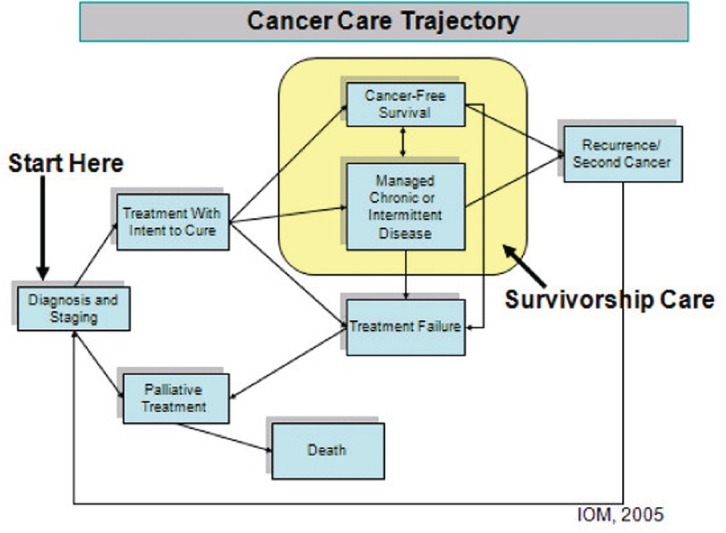
Cancer care trajectory and survivorship care. (Figure adapted from the Institute of Medicine. Reprinted with permission from Cancer Patient to Cancer Survivor: Lost in Transition, 2005, by the National Academy of Sciences, Courtesy of the National Academies Press, Washington, DC, USA and shown in Ganz [2].)